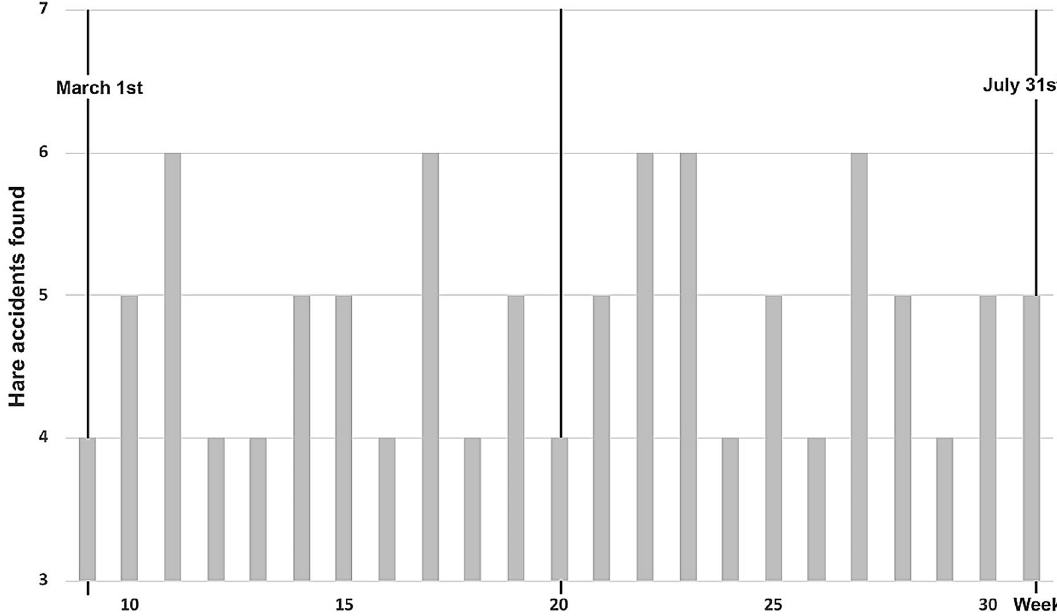
Figure 2. Weekly Iberian hare accidents during the study